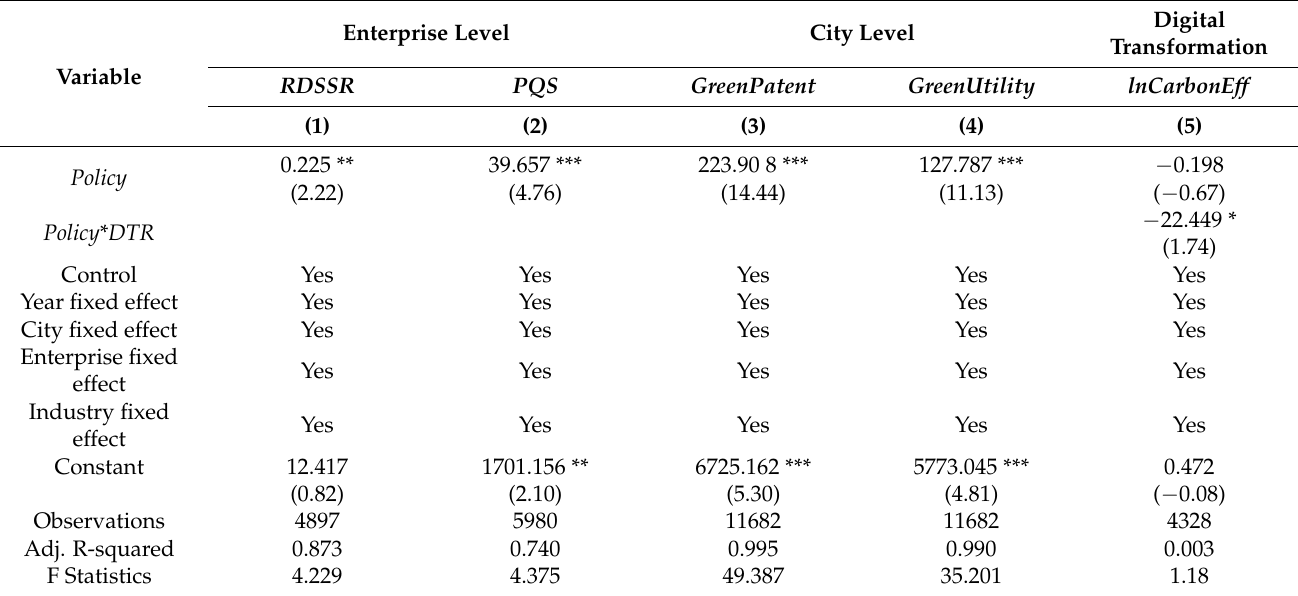
Table 7. Regression results of SCP on green innovation and digital